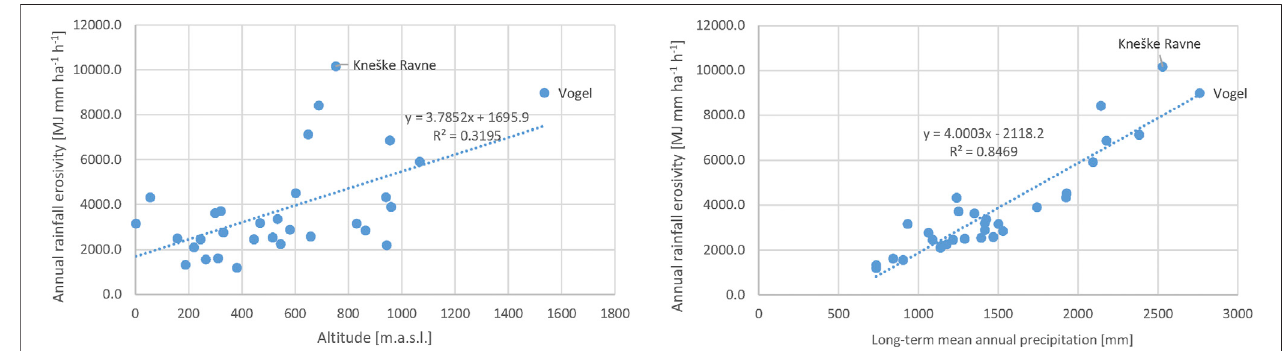
FIGURE 4 | Relationship between annual rainfall erosivity, altitude, and long-term mean annual precipitation (1999 – 2018) for the 31 Slovenian stations included in the REDES database. The names of the two stations that were also used in this study are written.